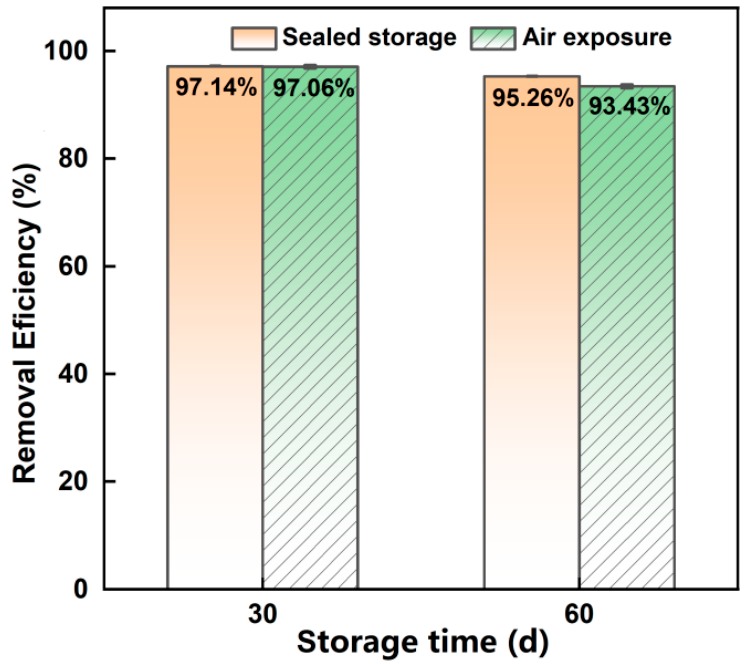
Figure 12. Exploration of storage time for LLC800.